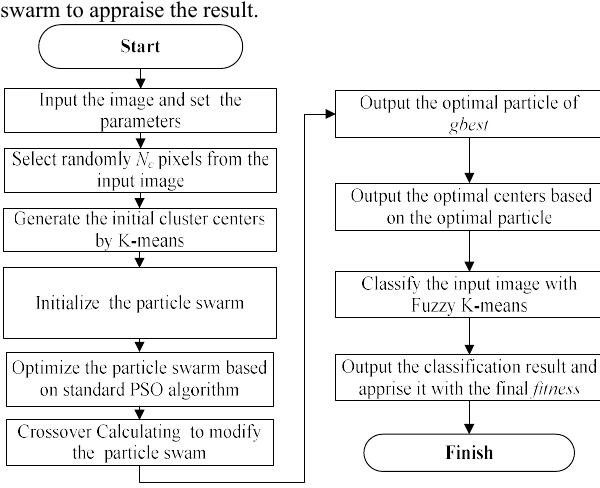
Figure. 2 The procedures of the IPSO-FKM algorithm